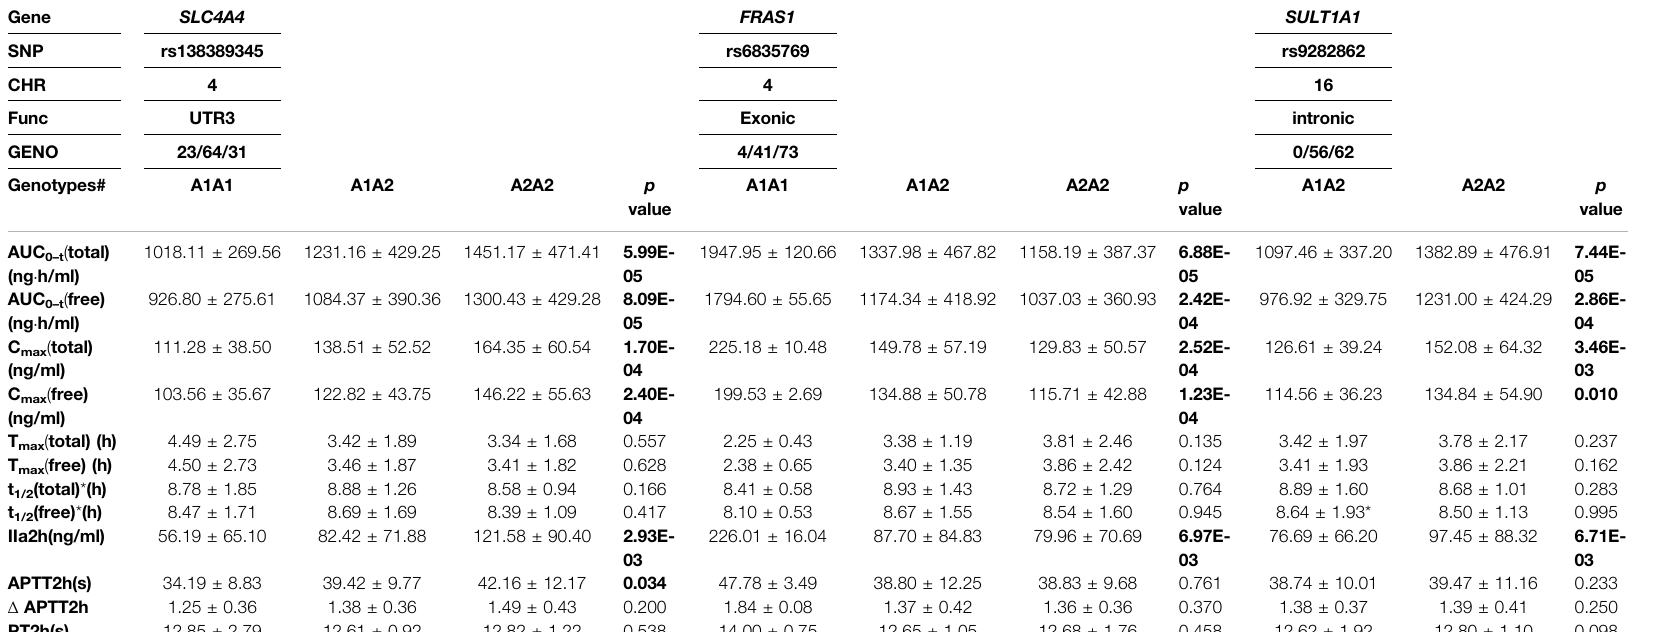
TABLE 2 | Effect of suggestive genetic variations on pharmacokinetic and pharmacodynamic parameters of dabigatran. Gene